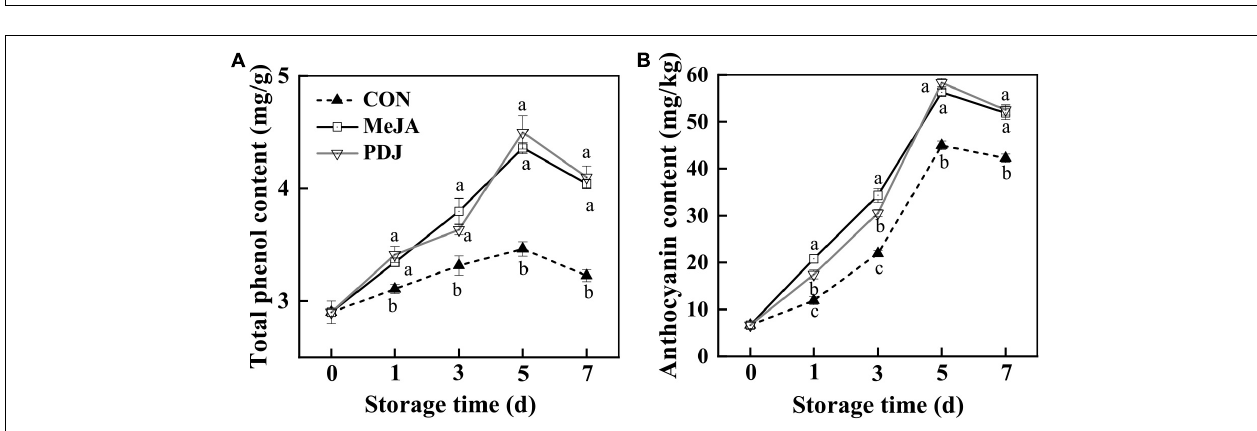
FIGURE 2 | Effects of postharvest jasmonate treatments on a* (A) , CIRG* (B) , b* (C) , and L* (D) values in the skin of peach fruits during storage (22 ± 2 ◦ C; light intensity 300–400 lux). Different lower-case letters indicate significant differences ( P < 0.05) from three treatments at the same time point.